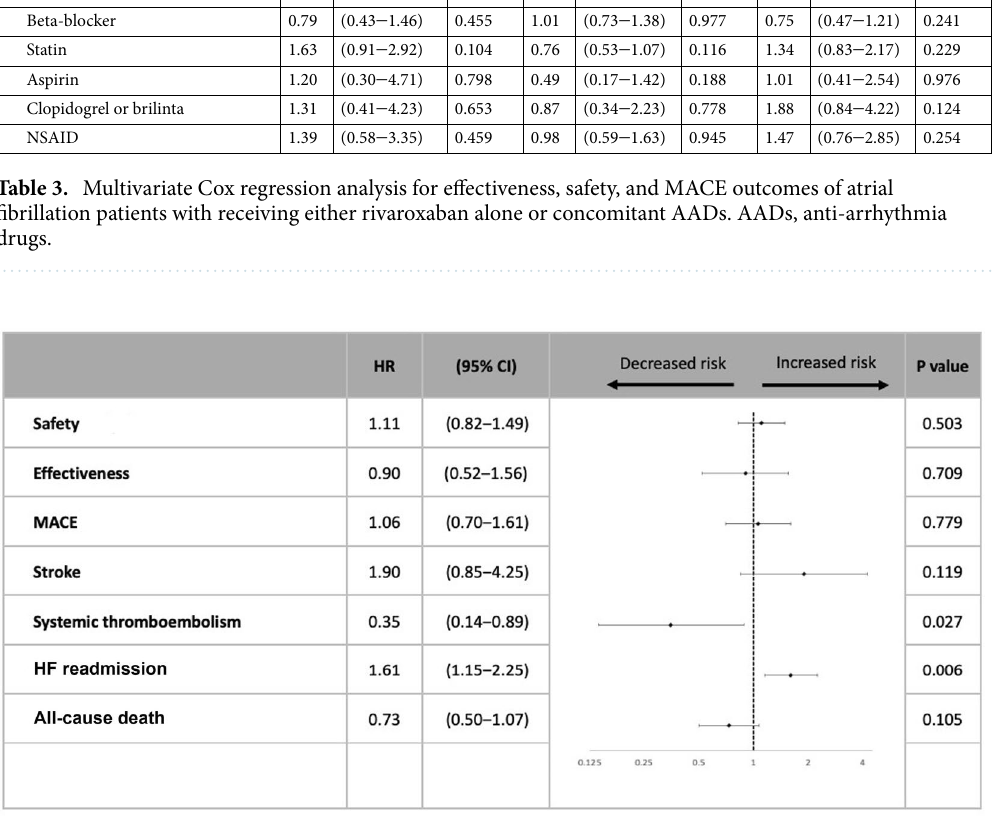
Figure 3. Comparing of multivariate Cox regression analysis for endpoints in patients with atrial fibrillation receiving rivaroxaban with concomitant